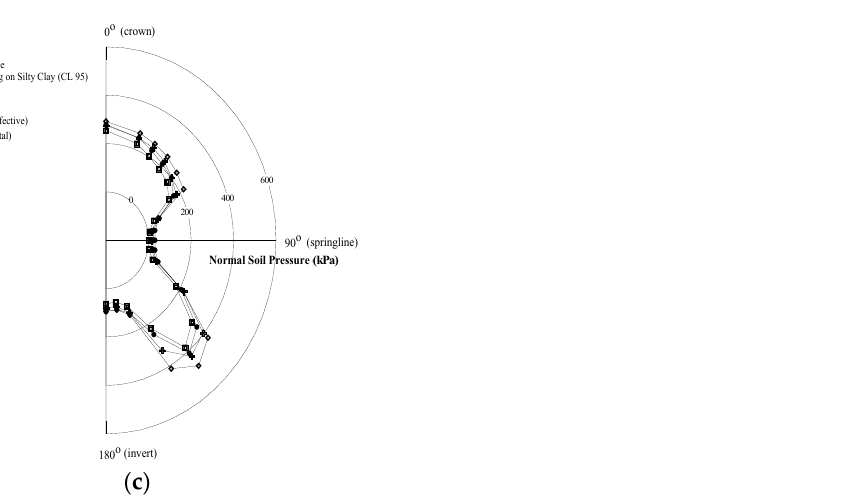
Figure 6. Variation in the normal soil pressure distributions for moist, saturated, and submerged conditions: ( a ) SW95, ( b ) ML95, and ( c ) CL95.